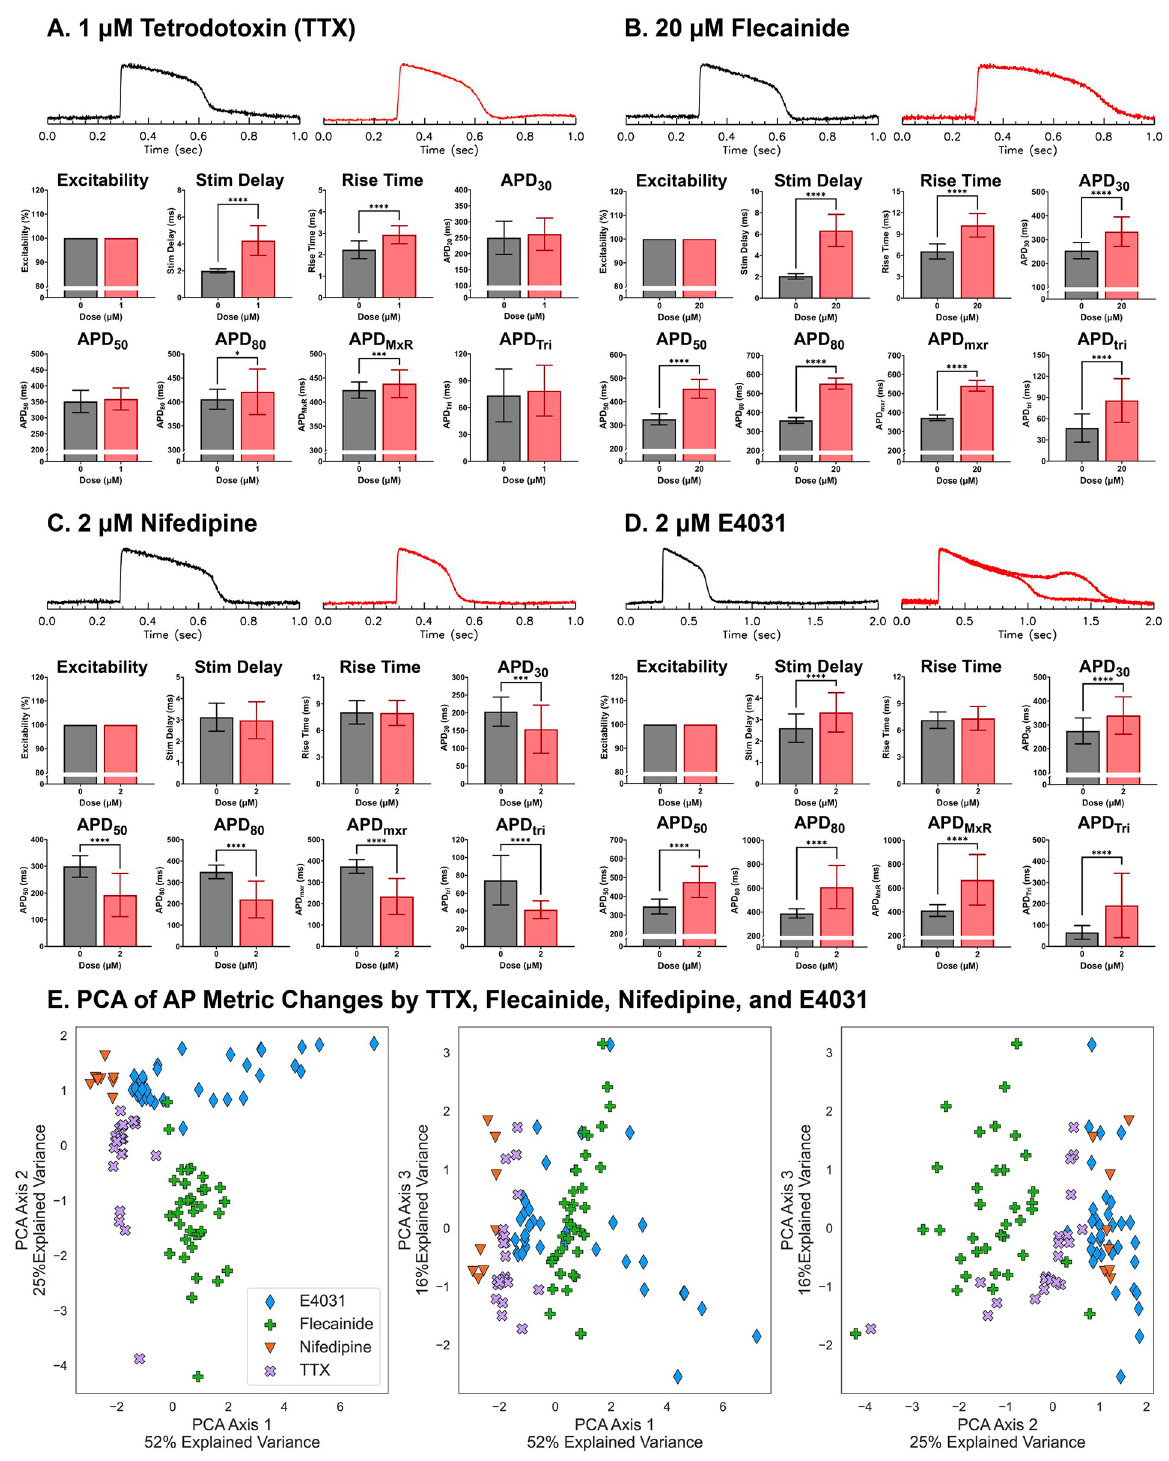
Fig 8. Experimental validation of AP metric changes in response to known ion channel blockers. Representative AP traces before and 15 to 30 mins after drug exposure at indicated concentration (top) and automatically quantified AP metrics from microtissues containing 5% hCF after 6~8 days in culture (bottom). (A) Tetrodotoxin (TTX, 1 μ M), a selective Na + channel blocker, increased stimulation delay and rise time and moderately increased APD 80 and APD mxr ( n = 32 microtissues). (B) Flecainide (20 μ M), a I Na and I Kr blocker, increased stimulation delay and rise time as well as APD 30 , APD 50 , APD 80 , APD mxr , and APD tri (n = 35 microtissues). The increase ion APD tri is caused by larger prolongation of